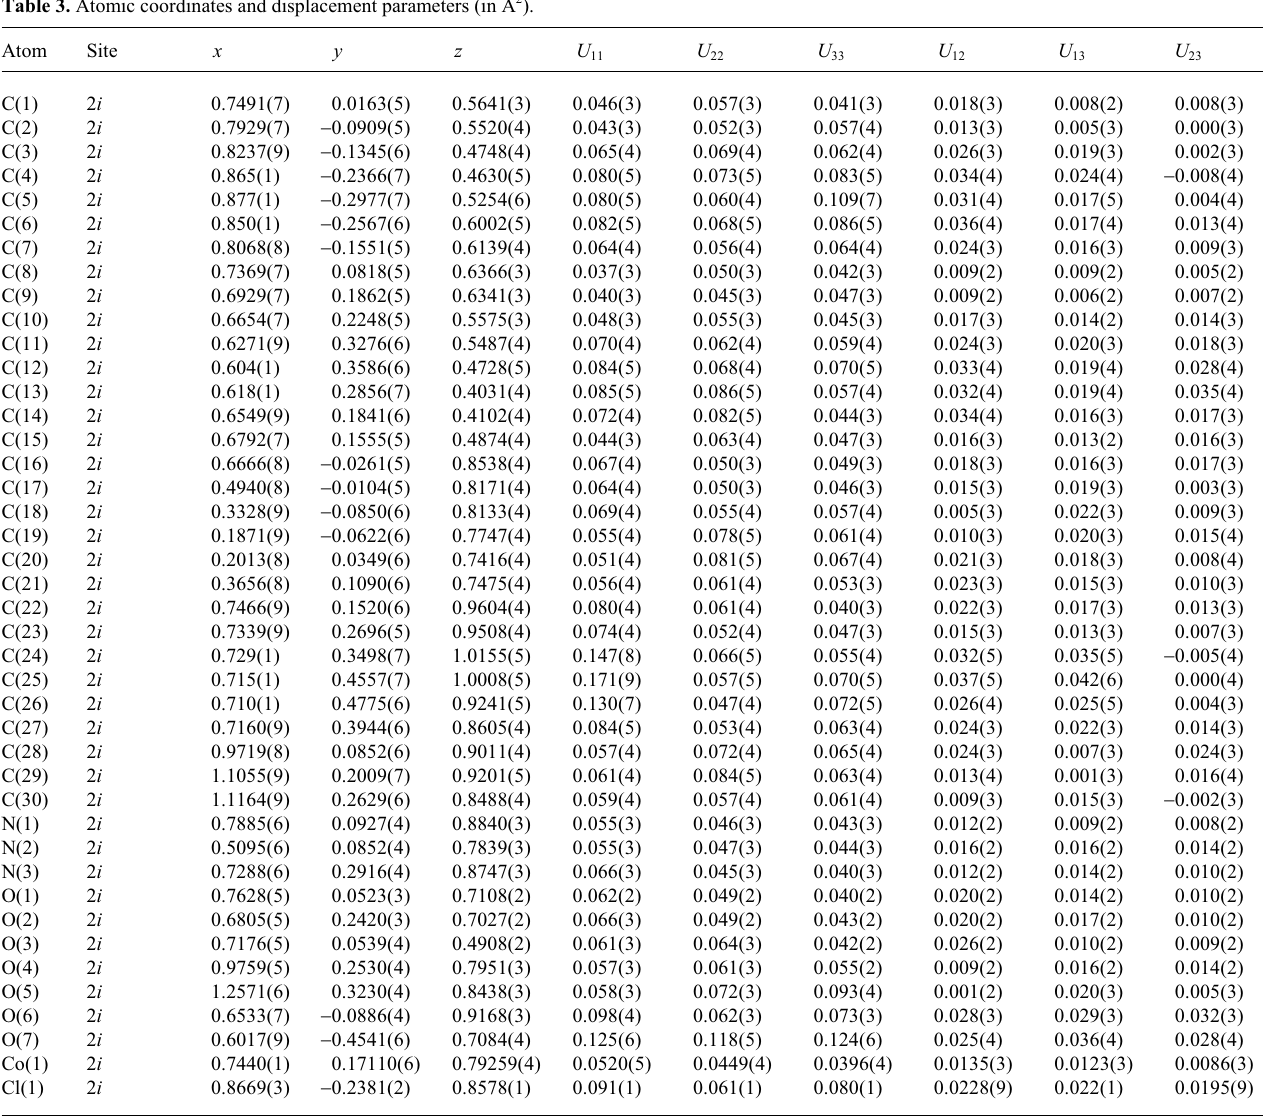
Table 3. Atomic coordinates and displacement parameters (in Å 2 ).